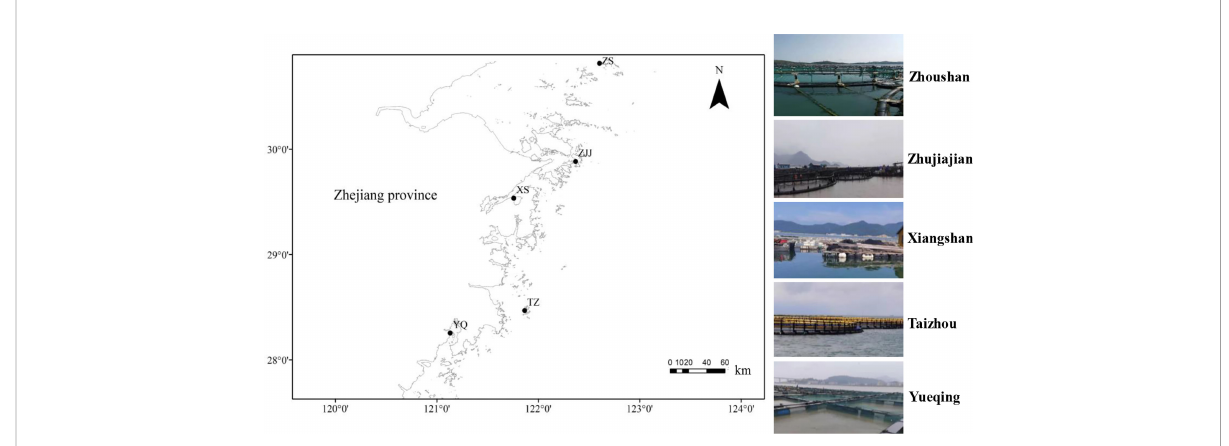
FIGURE 1 Geographic location of sampling sites from fi ve large yellow croaker farms in Zhejiang province, China. Three parallel samples for seawater and sediment (excluding the sampling site ZS) were collected from three different cages in each surveyed